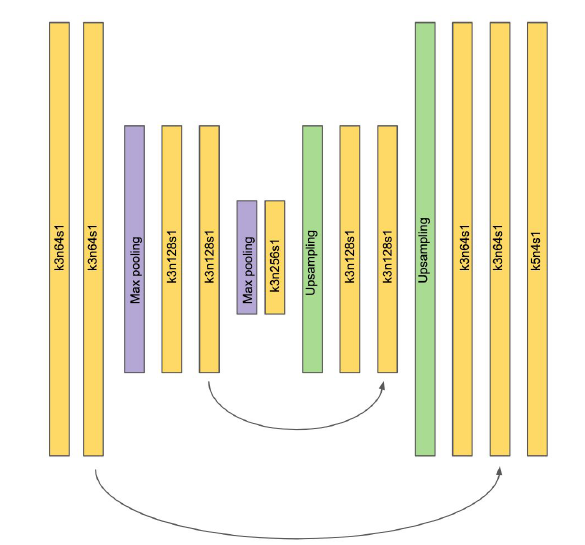
Figure 1. Architecture of the autoencoder network (AESR). Yellow rectangles represent convolutional layers with kernel size k, n feature maps and stride s. Purple rectangles represent max pooling and green rectangles upsampling layers. Arrows indicate skip